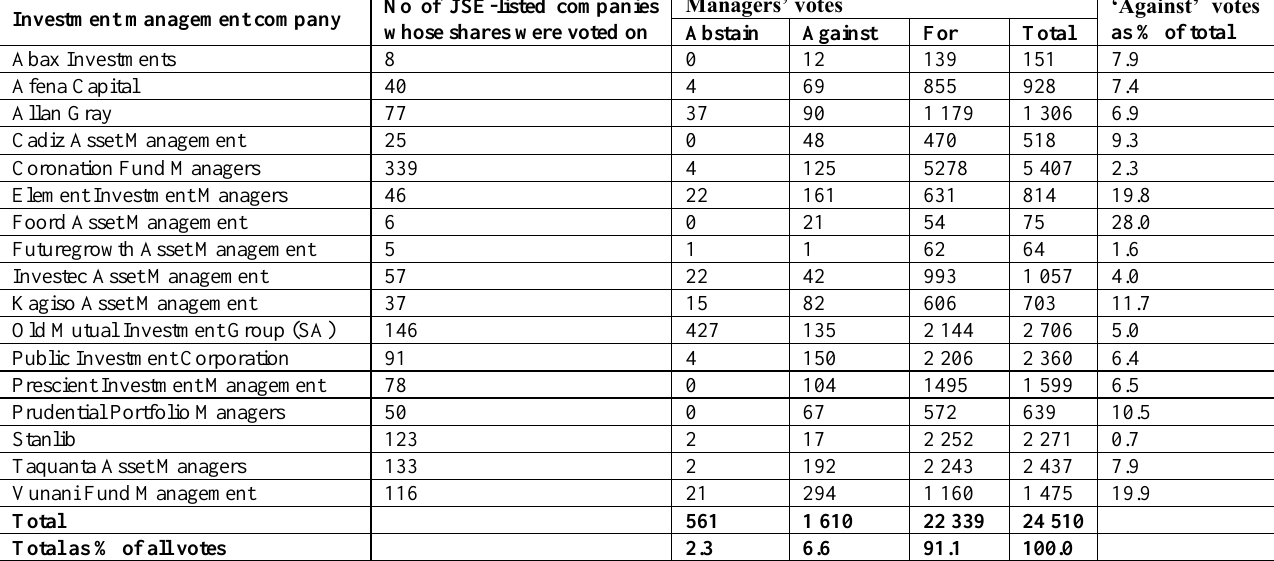
Table 3: Proxy voting results